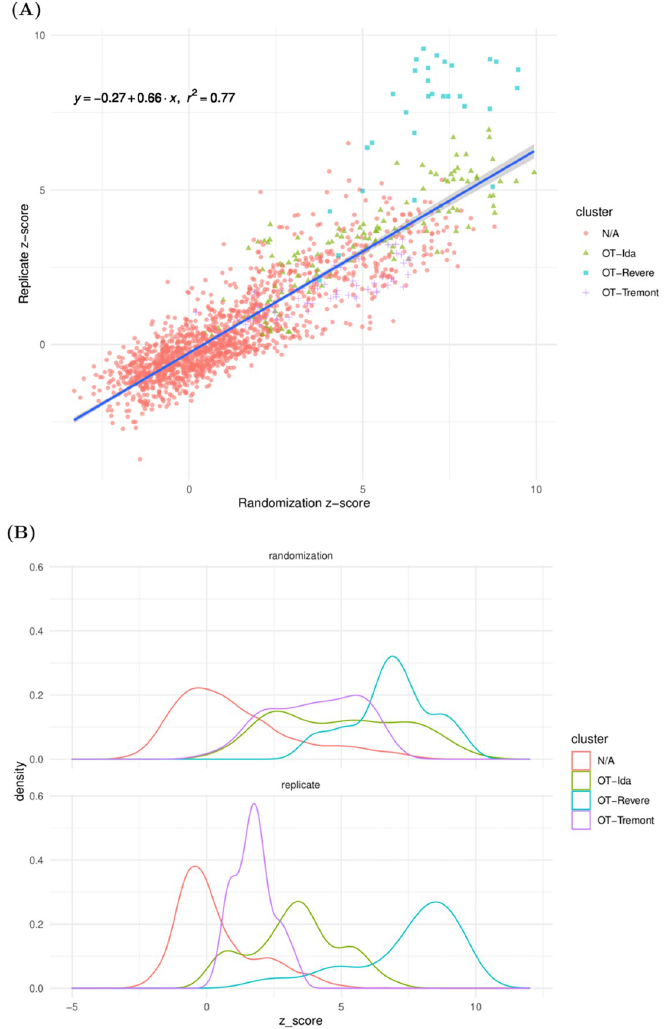
Fig 7. Visualizations of the relationship between replicate and randomization z-scores. (A) Scatterplot of replicate z-scores versus randomization z-scores. (B) Marginal density estimates of replicate z-scores and randomization z- scores. We see strong evidence of a significantly positive linear relationship between these quantities, suggesting that our randomization procedure is able to identify significant differences between repertoire datasets.